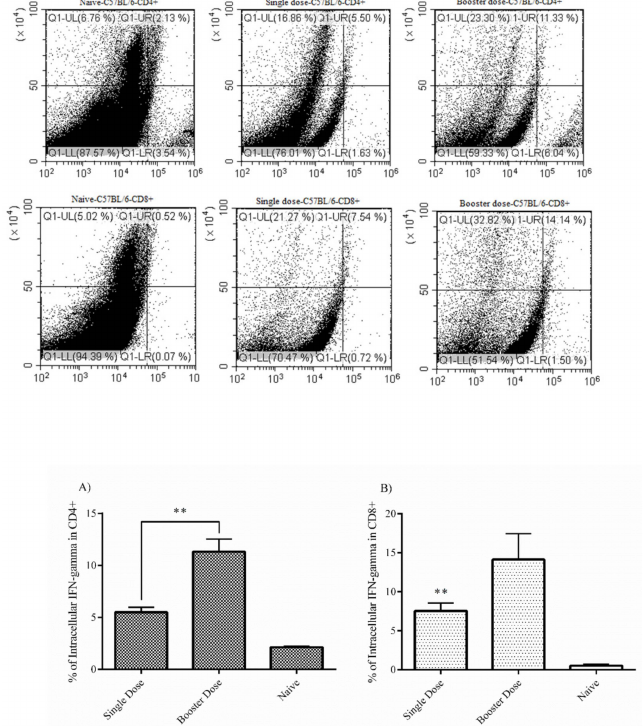
Figure 4. Intracellular IFN-gamma staining. CD4 + and CD8a + T cells from immunized C57BL / 6 mice (4 weeks after the final injection of mRNA construct) were separated in vitro and intracellular IFN-gamma staining was separately performed in each cell population. ( A ) Based on the flow cytometry analysis, the booster dose group clearly has more potential to stimulate the production of IFN-gamma cytokine in the CD4 + T cell population. ( B ) The results for the CD8a + cells are similar to those for the CD4 + cell population, indicating that the booster dose has a stronger e ff ect than the single dose. As a control, we used naive splenocyte cells from the negative control group. The data was analyzed using the log-rank test (* P < 0.05; ** P < 0.01; and *** P < 0.001) and presented as mean ± SD. Error bars indicate standard deviation